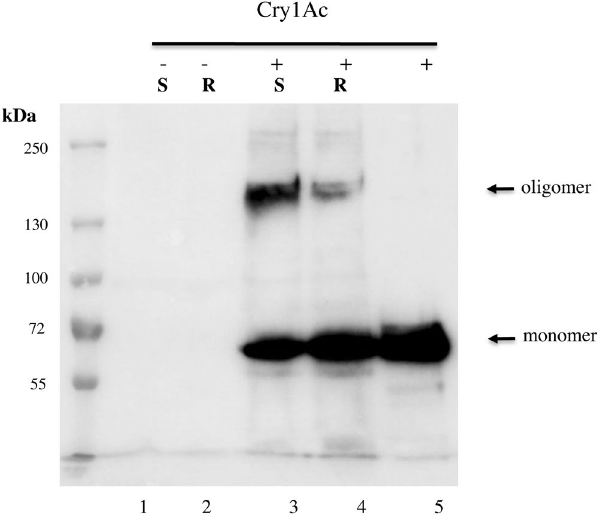
Figure 3. Oligomerization of Cry1Ac in the presence of BBMV from susceptible and resistant populations of P. xylostella . Cry1Ac activated toxin (1.5 μ g) was incubated with BBMV (20 μ g) from P. xylostella susceptible Geneva 88 or resistant NO-QAGE, the whole sample was separated by SDS-PAGE after three min heating at 60 °C and revealed in western blot using anti-Cry1Ac antibody as described in Experimental procedures. Lane 1, BBMV from Geneva 88; lane 2, BBMV from NO-QAGE; lane 3, Cry1Ac incubated with BBMV from Geneva 88; lane 4, Cry1Ac incubated with BBMV from NO-QAGE; lane 5, Cry1Ac toxin without BBMV.